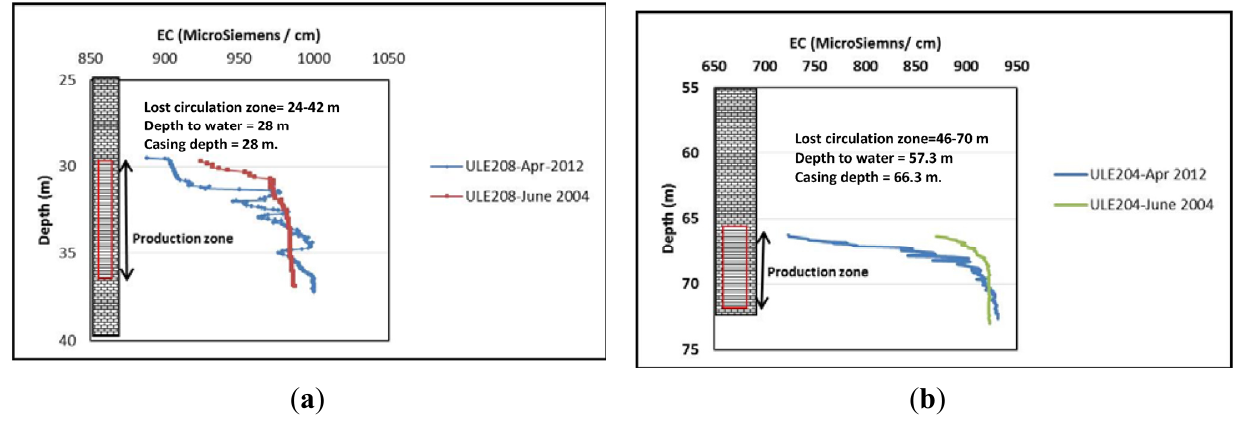
Figure 8. Salinity stratification influenced by conduit porosity in QL aquifer ( a ) ULE208 and ( b ) ULE